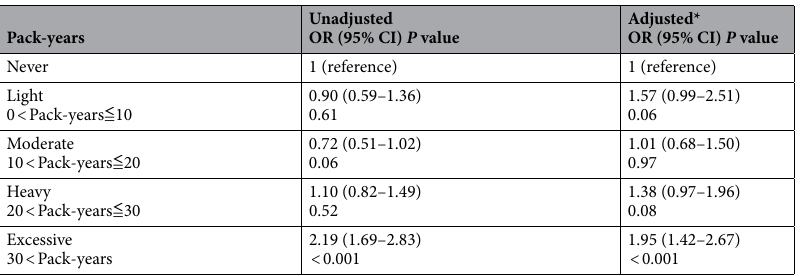
Table 5. Odds ratios and 95% confidence intervals for low quartile of FMD according to pack-years in never smokers and current smokers in men. FMD, flow-mediated vasodilation. Low quartile of FMD indicates less than 4.08%. *Adjusted also for age (≥ 65 years), body mass index, systolic blood pressure, low-density lipoprotein cholesterol, glucose, and year of